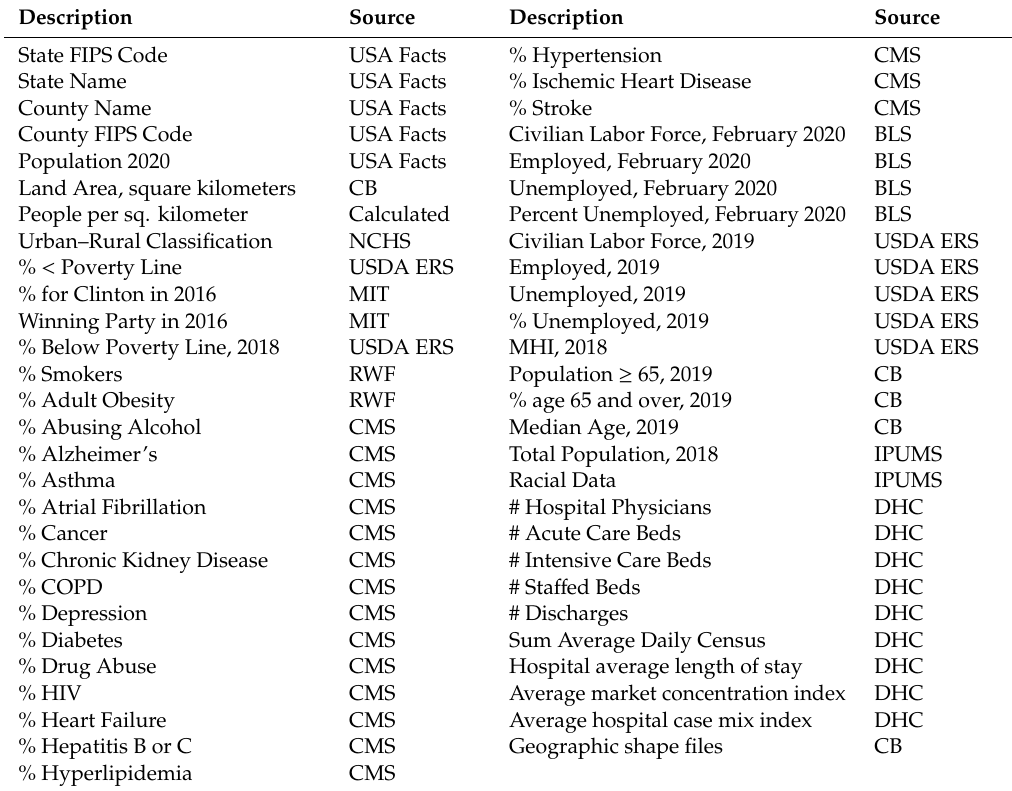
Table A1. Independent Variables Considered in the